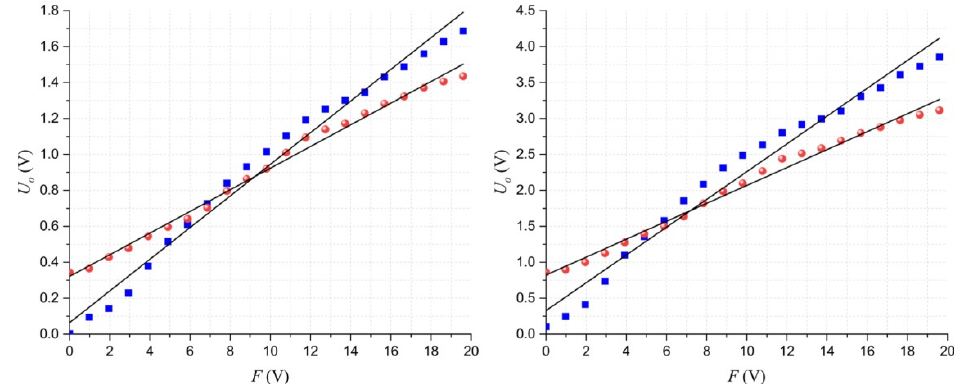
Figure 3. Plots of the output voltage ( U o ) as a function of the applied force ( F ) for two different specimens at different input voltages ( U ). The fit to (7) has been overlaid in both cases. The sensor where percolation dominates is shown with red spherical markers; the sensor where quantum tunneling dominates is shown with blue square markers. Data taken at ( left ) U = 3 V and ( right ) U = 6